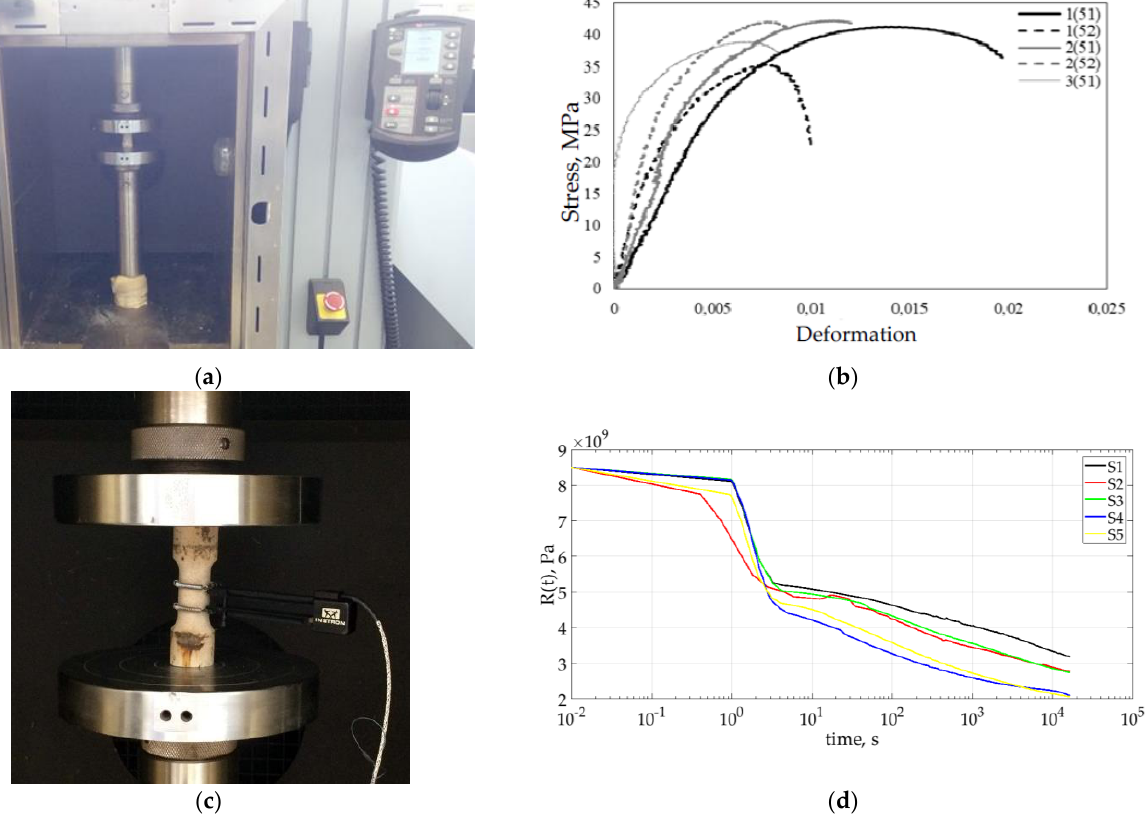
Figure 2. Compression testing of cylindrical samples: ( a ) with test system tooling used during tests, ( b ) compression strain diagram at 22°C, ( c ) sample before the compression stress relaxation test, ( d ) compressive stress relaxation at 22°C.